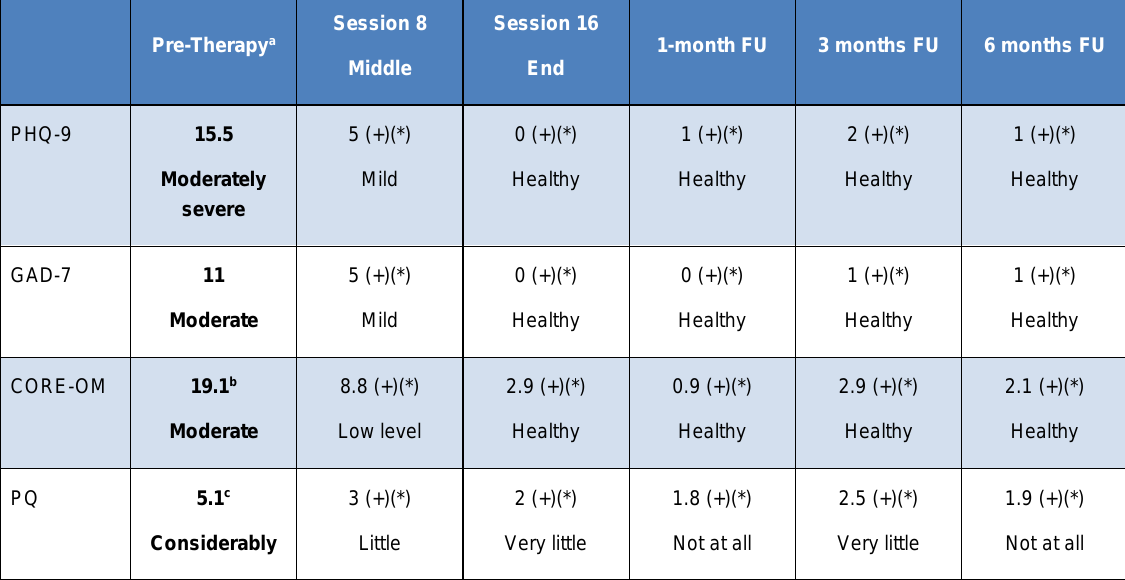
years, one lasting from 3 to 5 years, three lasting from 1 to 2 years, and three from 6 to 11 months. Eight out of ten problems showed a clinically significant and reliable improvement by the end of the therapy, maintained in the 1-month follow-up. In the 3-month follow-up, six problems had a RCSI, whereas in the